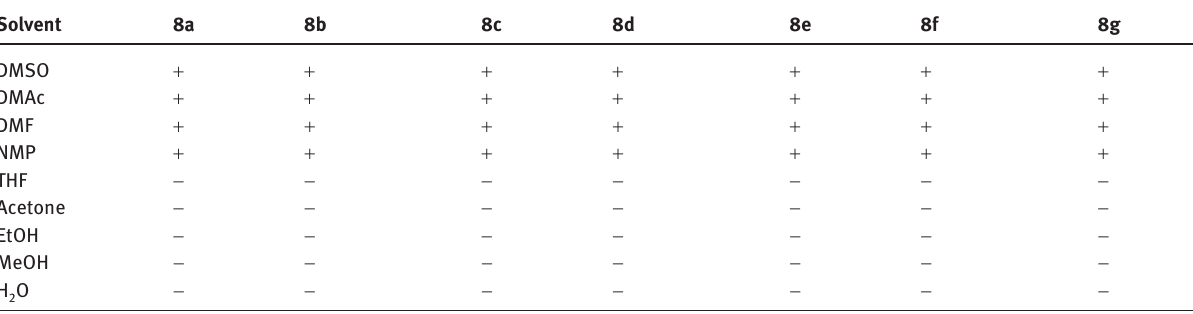
Table 3: Solubility of PAIs ( 8a–g